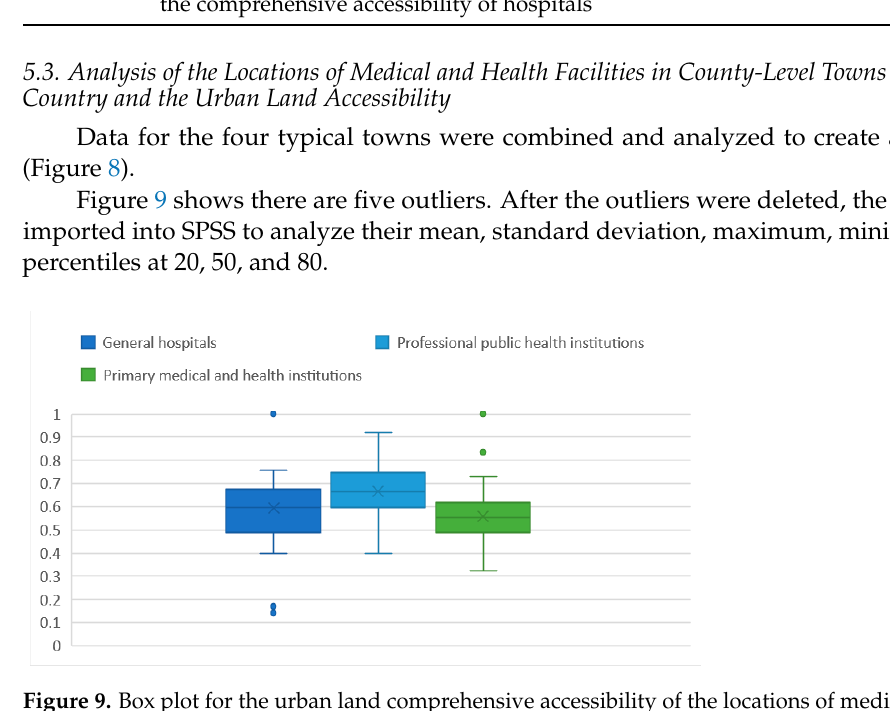
Figure 9. Box plot for the urban land comprehensive accessibility of the locations of medical facilities at all levels in a typical county.